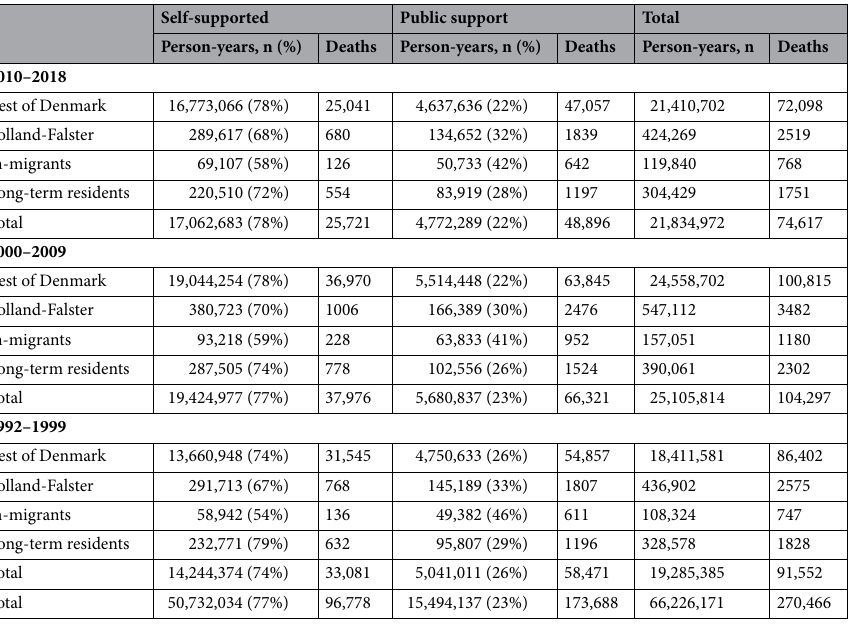
Table 1. Number of person-years and deaths for people aged 30–64 years by residency group, economic status, and